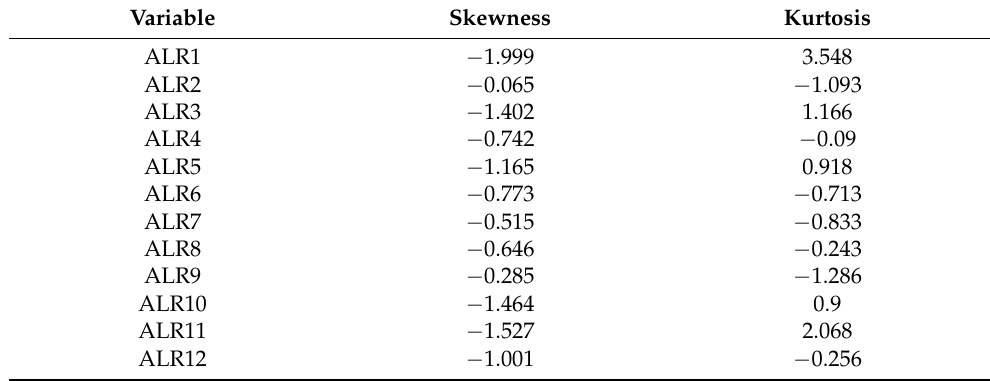
Table 4. Skewness and